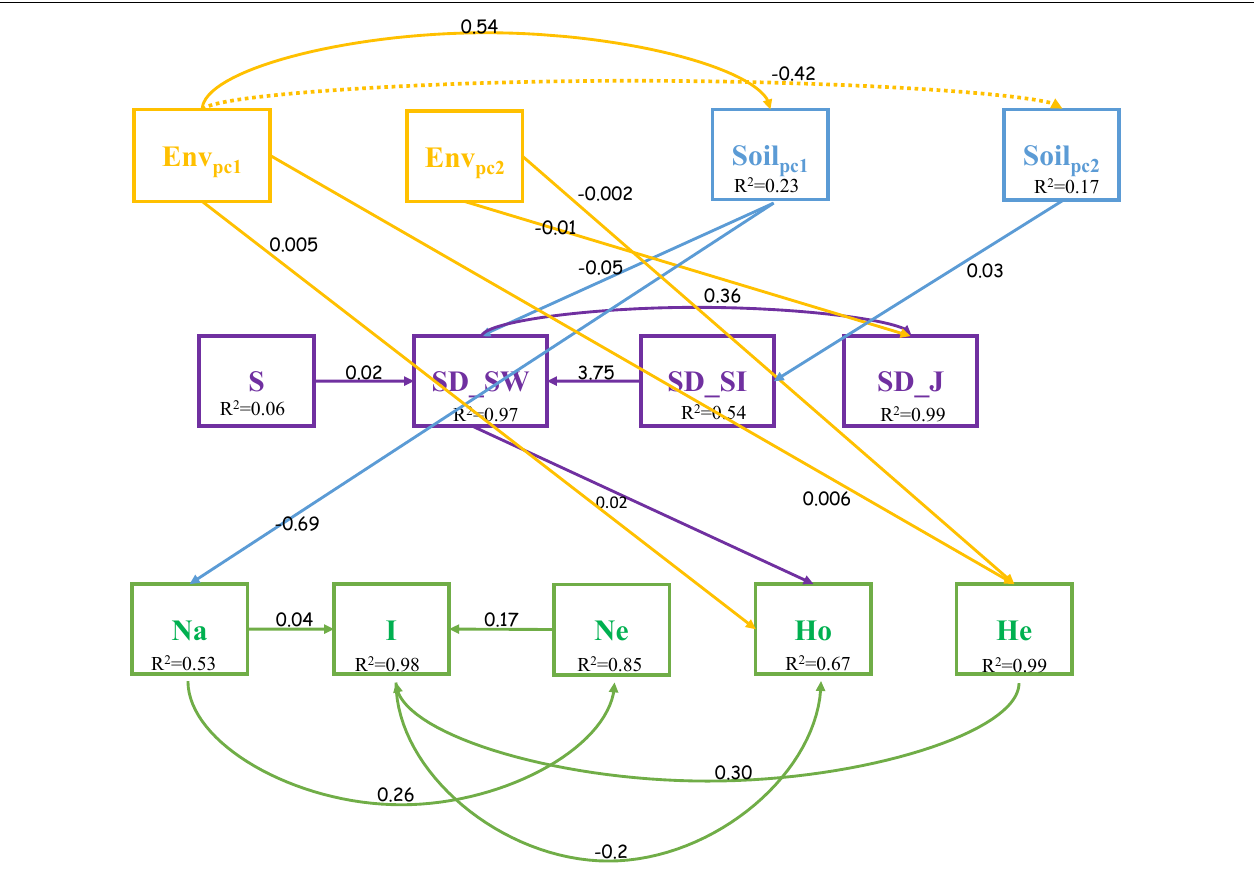
FIGURE 5 | Path diagrams for analyzing the relationship between topography, soil properties, community assembly, and genetic structure (Fisher C = 46.355, P -value = 0.902). Env pc 1 , PC 1 for topography; Env pc 2 , PC 2 for topography; Soil pc 1 , PC 1 for Soil; Soil pc 2 , PC 2 for Soil.